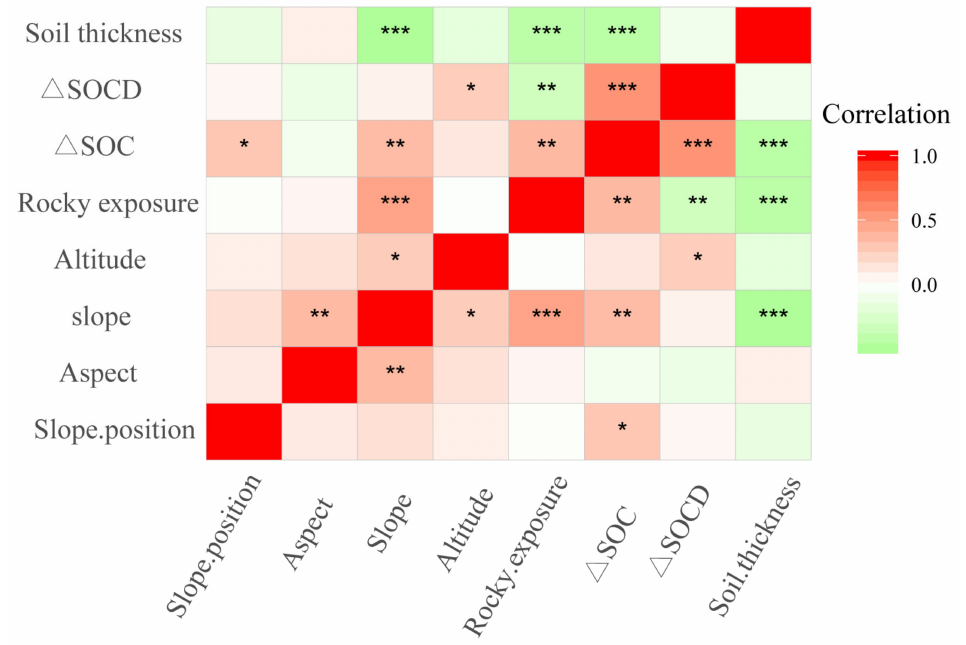
Figure 5. Two-dimensional ordination map of soil organic carbon and topographic factors in cultivated land of Karst Plateau. (”*” represents = 0.01–0.05 ( p value), ”**” represents 0.001–0.01 ( p value) and ”***” represents < 0.001 ( p value))